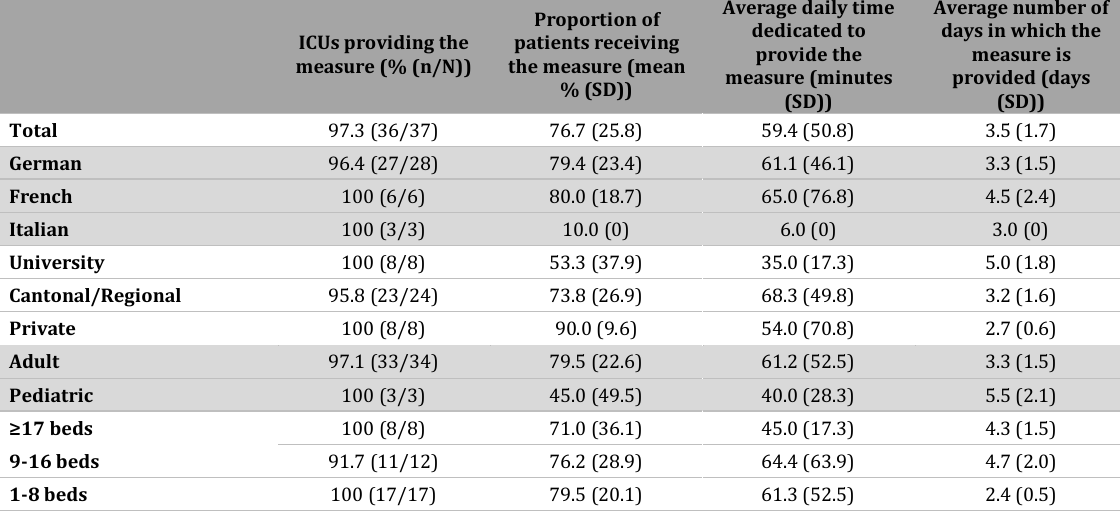
Table S14. Transfers from bed to a chair